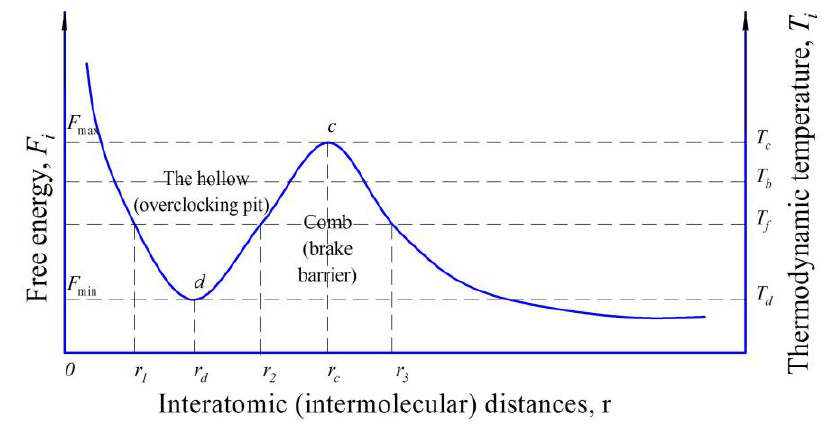
Fig. 1. Diagram of the state of atomic-molecular bonds of local regions of the material as a function of free energy and thermodynamic temperature from the interatomic (intermolecular)